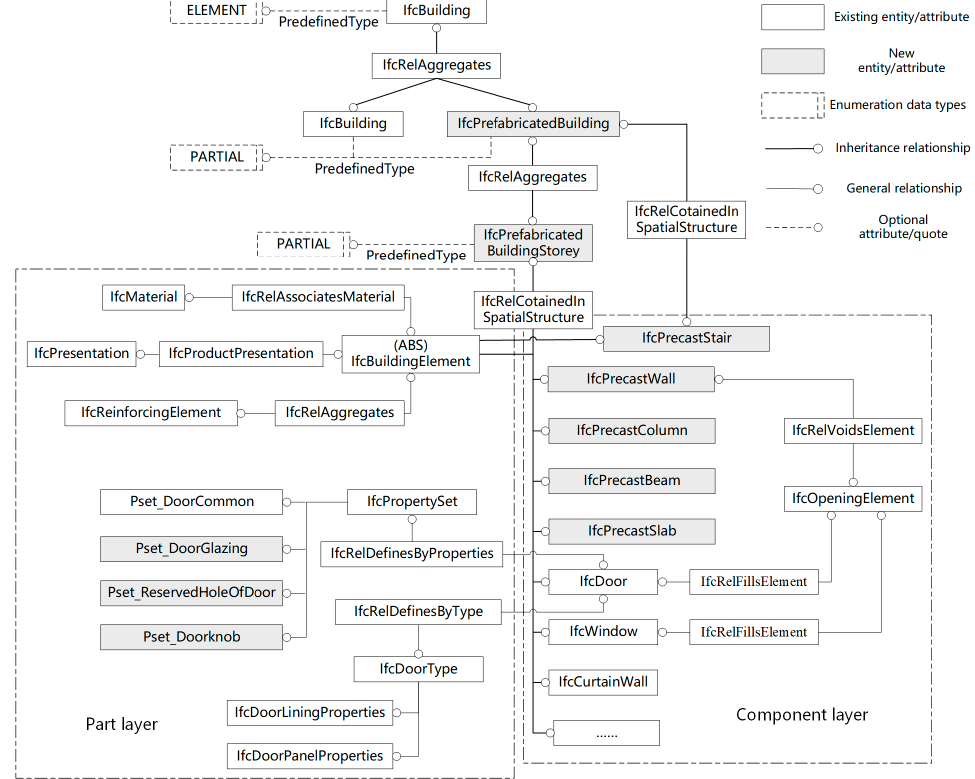
Figure 8. EXPRESS-G diagram for extended assembly model.